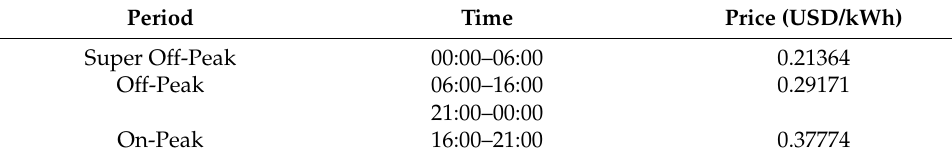
Table 1. SDGE time-of-use pricing rate in summer.